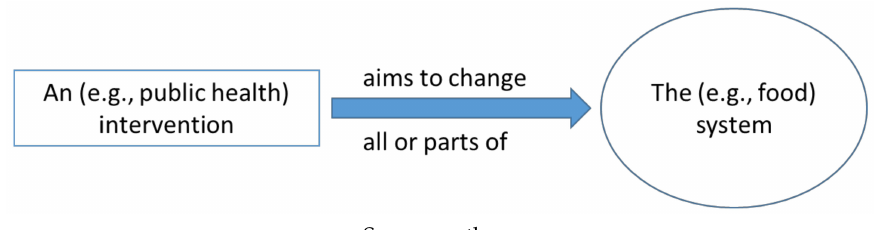
Figure 1. How a public health intervention is conventionally